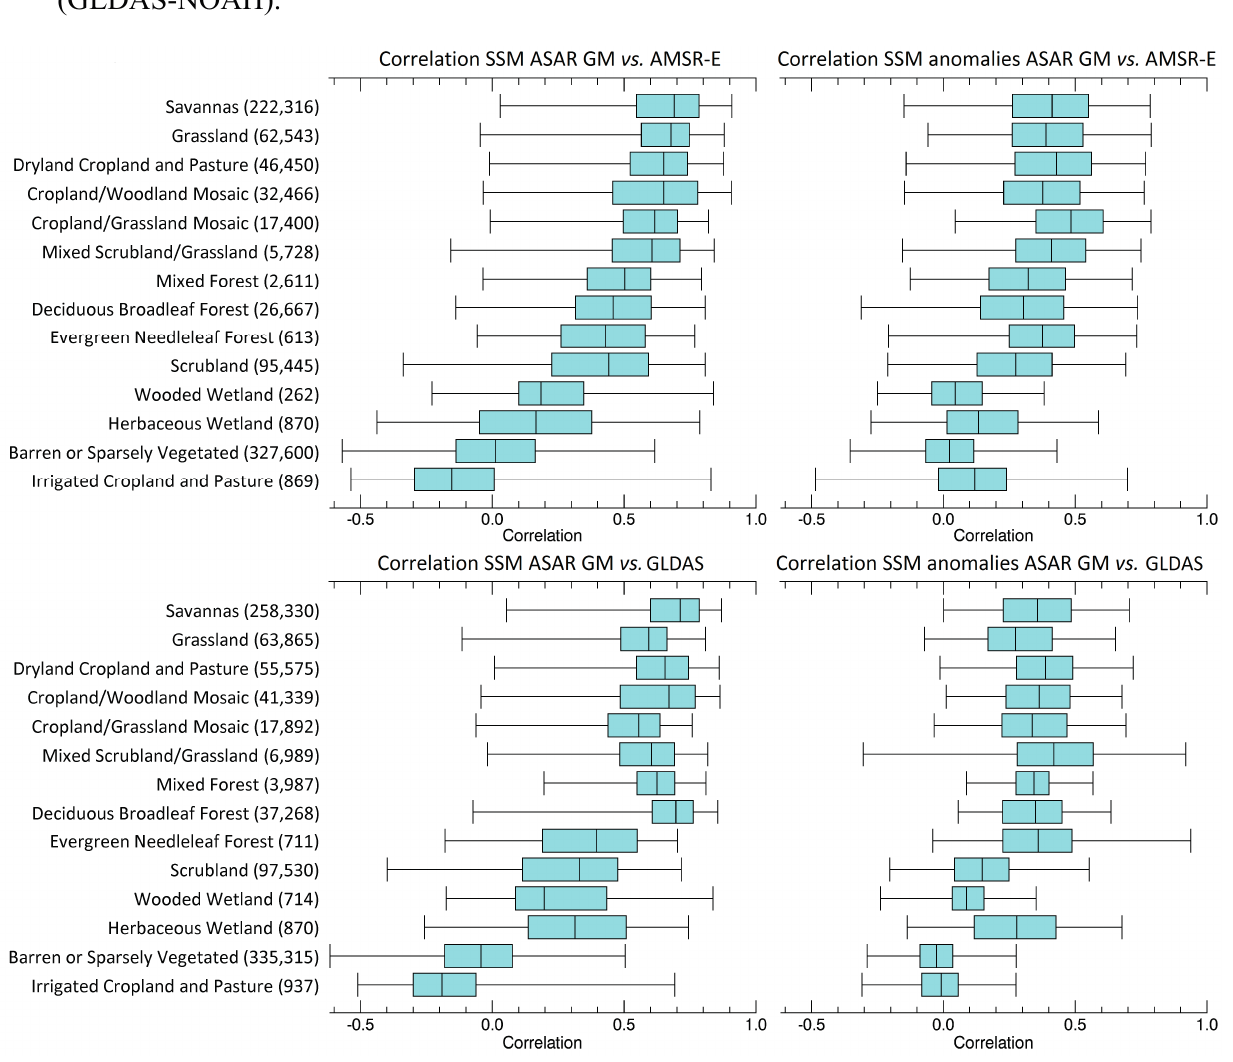
Figure 5. The box-plot representation of the correlation results stratified by the Land use/Land Cover system from U.S. Geological Survey Global Land Cover Characteristics. The boxes show the median, 25th and 75th percentiles; the lines represent minimum and maximum values after outlier removal (first and 99th percentile). The amount of 5-km Advanced Synthetic Aperture Radar (ASAR) pixels used for the evaluation for each class is shown in brackets behind the class name. ( Left ) The original Surface Soil Moisture (SSM) values; ( Right ) SSM anomalies. ( Top ) ASAR Global Monitoring (GM) mode vs. Advanced Microwave Scanning Radiometer for Earth Observing System (AMSR-E); ( Bottom ) ASAR GM vs. the Noah model from the Global Land Data Assimilation System